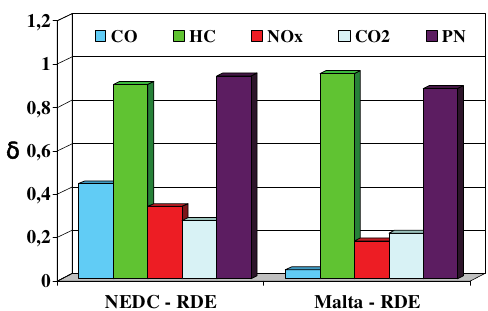
Fig. 23. Relative difference of the mean road emission of individual gase- ous pollutants and the mean particle number – d for the NEDC test and the modeled values from the RDE test, as well as for the Malta test and the modeled values from the RDE